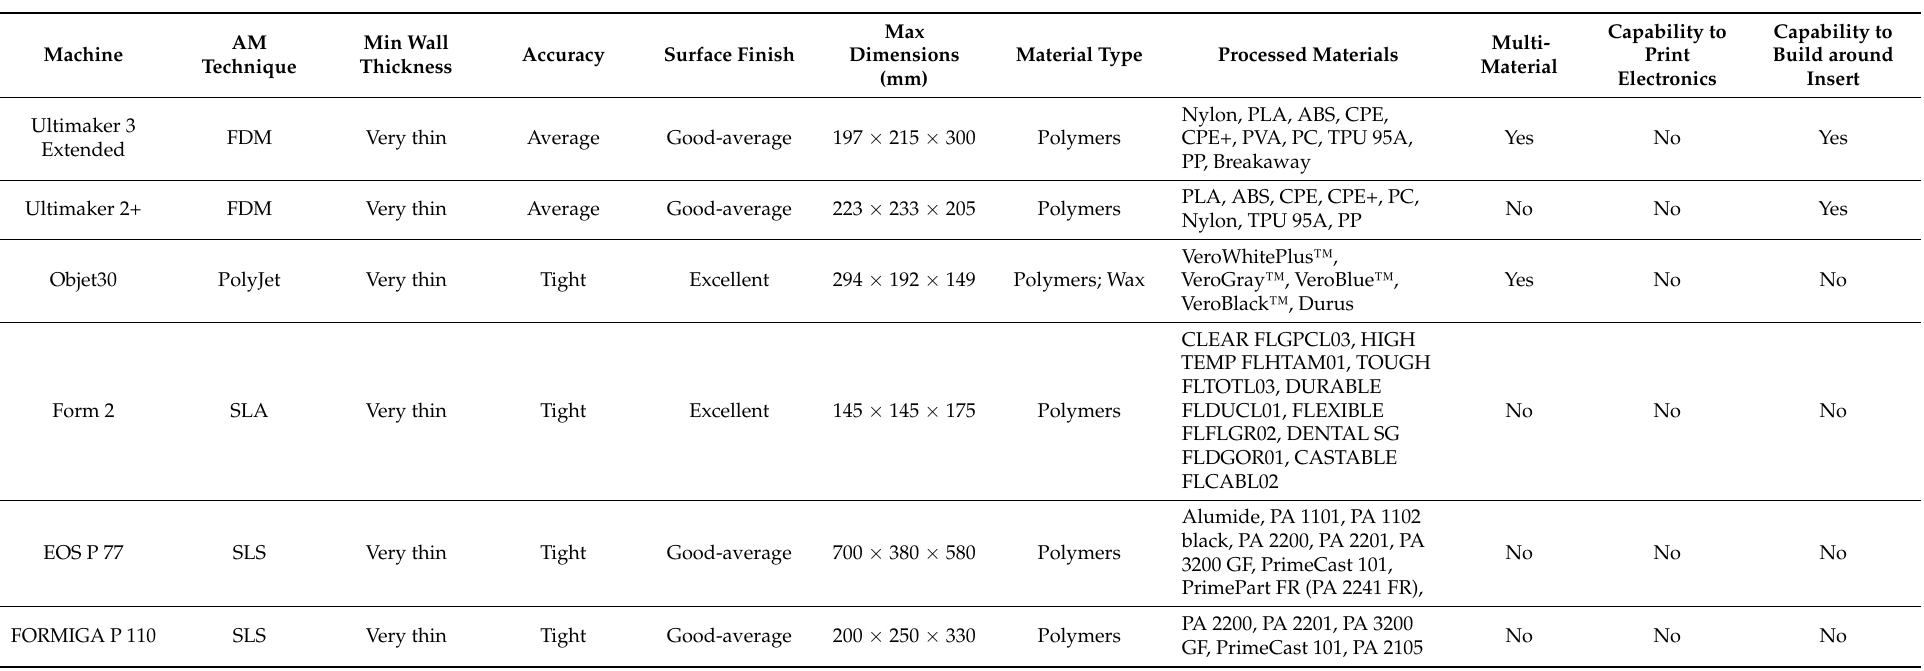
Table A1. Available AM